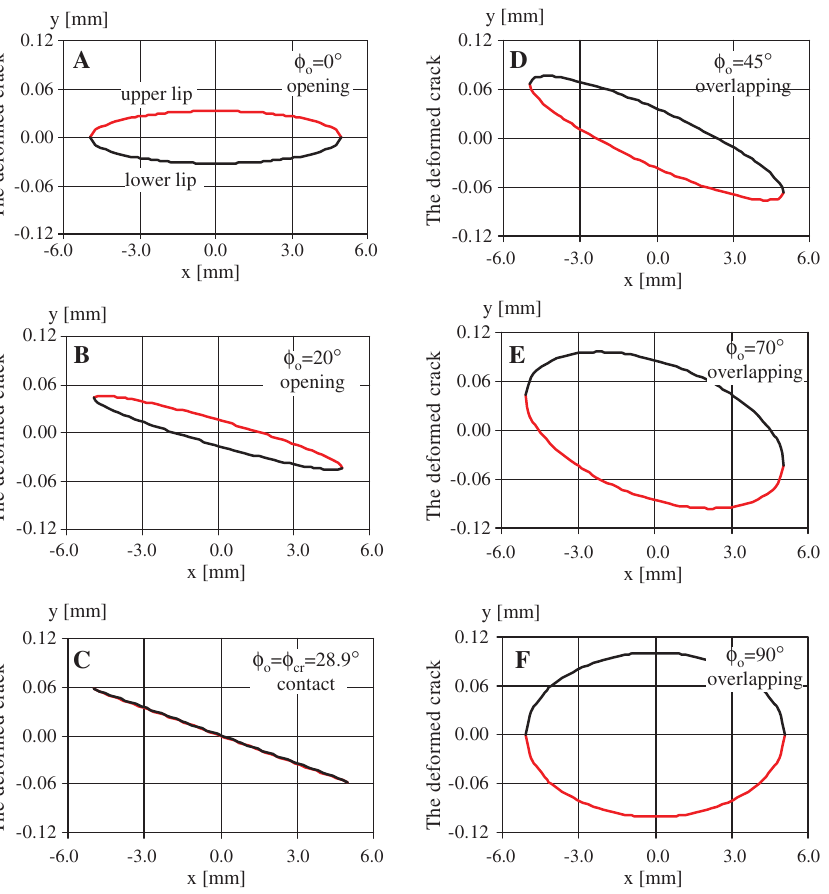
Figure 2 The exact shape of the deformed crack for various crack-axis inclinations: A and B correspond to opening cracks, C to a crack with lips in contact, and D–F to cracks with “overlapping”